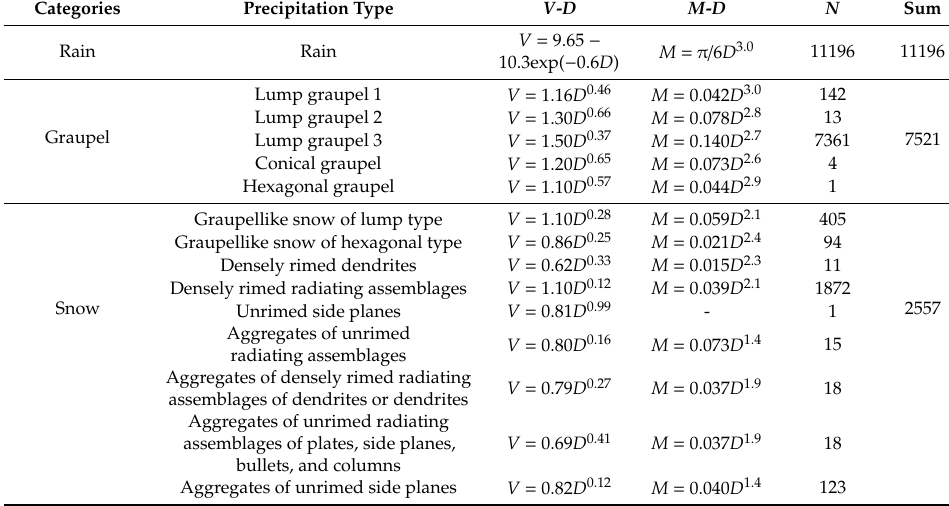
Table 2. Empirical relationships of V (m / s)- D (mm) and M (mg)- D (mm) for di ff erent types of precipitation. The empirical relationships of graupel and snow are derived from Locatelli and Hobbs [36]. The empirical relationships of rain are derived from Atlas et al. [38]. The sample number N of each precipitation type and the total number Sum of samples for each category are also